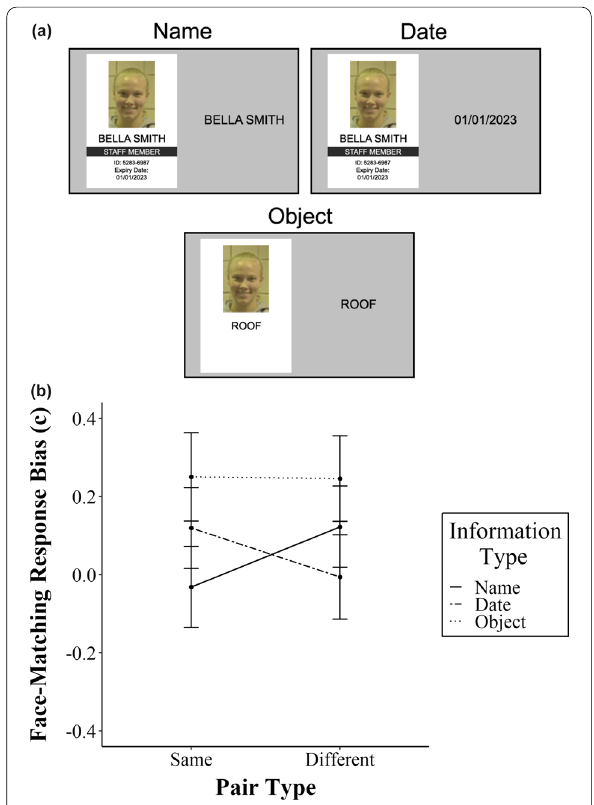
Fig. 5 a Trial examples of the name, date, and object context pair types in Experiment 4. In the name and date pair type conditions, participants were shown an ID card similar to that in Fig. 3a, but for the addition of expiry date information. In the object-matching condition, participants were shown a white frame with an object label under the facial image. b Experiment 4 criterion scores as a function of context pair type and context condition. All error bars represent standard